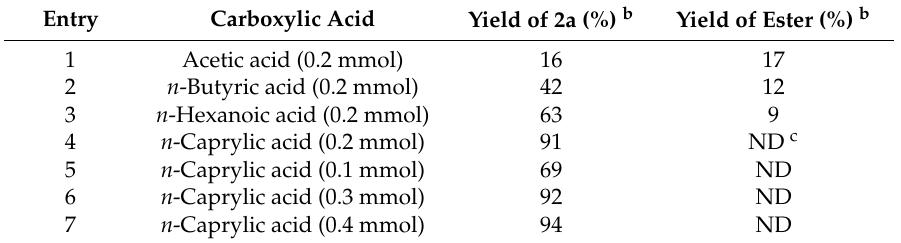
Table 2. The effect of carboxylic acid on the oxidation of salicyl alcohol a .